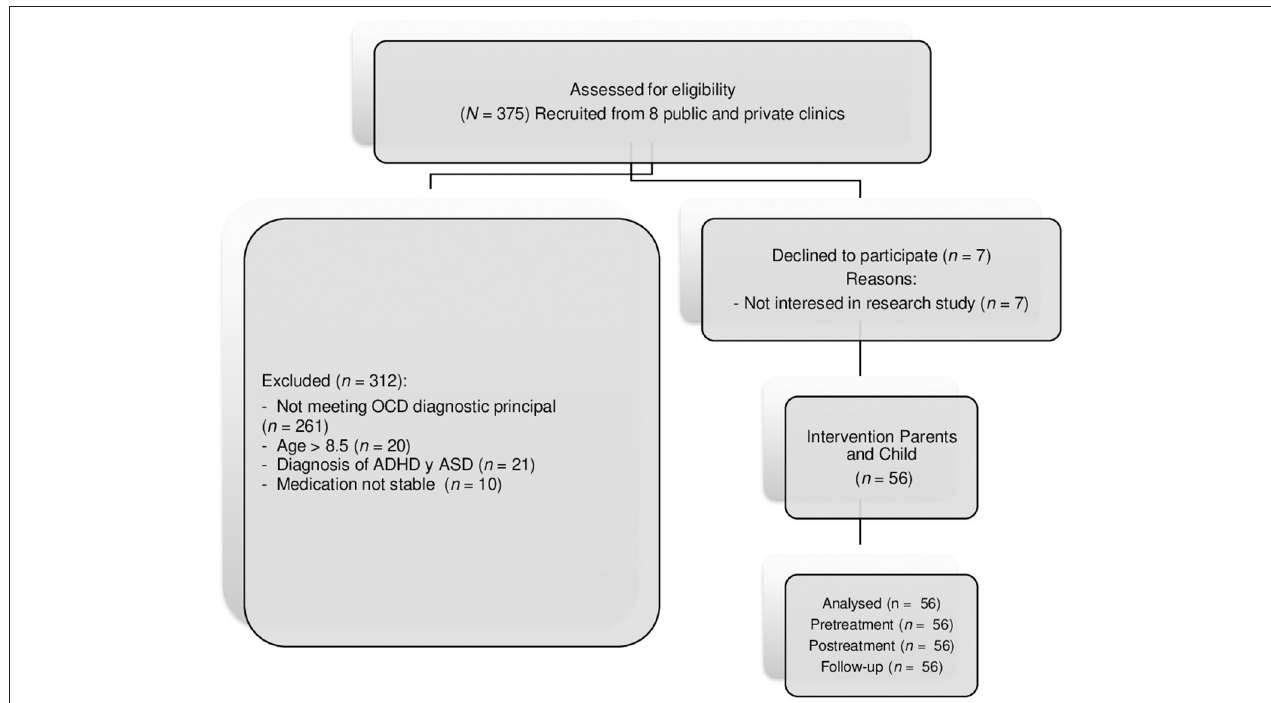
FIGURE 1 | CONSORT flow diagram of study development. OCD, Obsessive-Compulsive disorder; ADHD, Attention deficit hyperactivity disorder; ASD, Autism spectrum